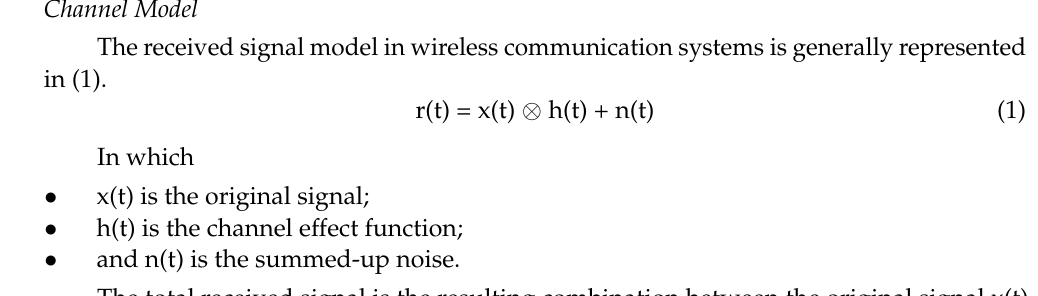
Figure 4. Rough Power and Frequency Data Filtering according to their frequency band.